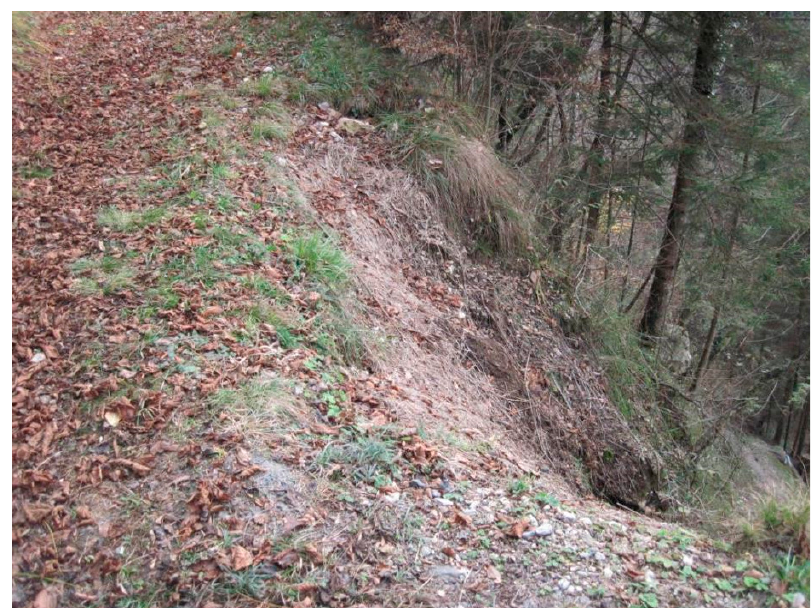
Figure 5. Landslide photograph code 025021_03c.